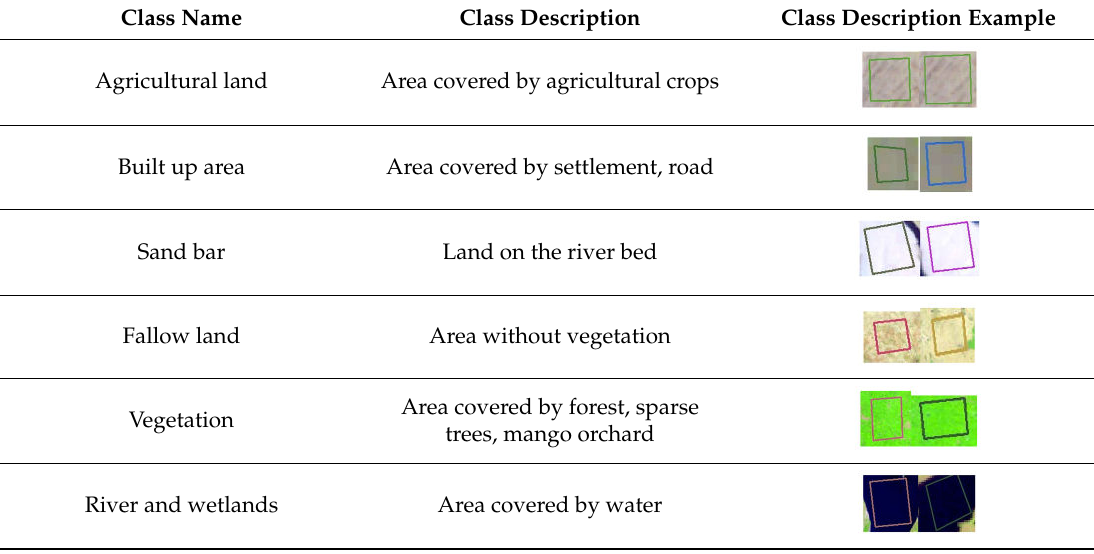
Figure 1. Location map and details of the study area. Table 1. Description of the land-use / land-cover (LULC) classes